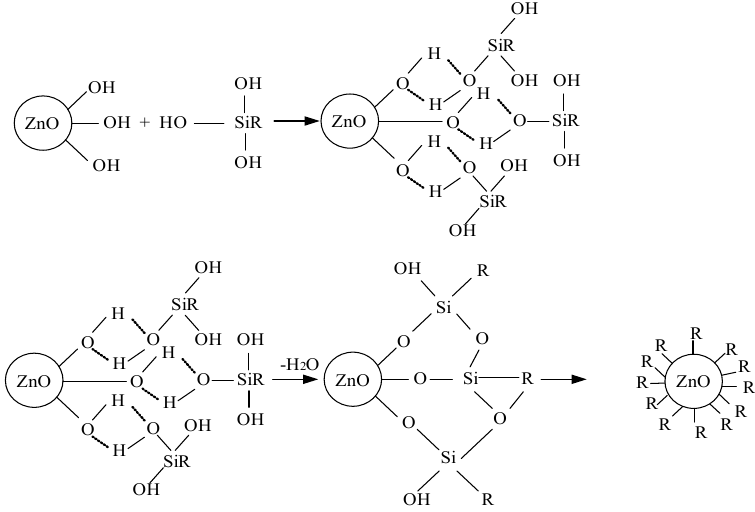
Figure 3. Surface modification of nano-ZnO with silane coupling agent.